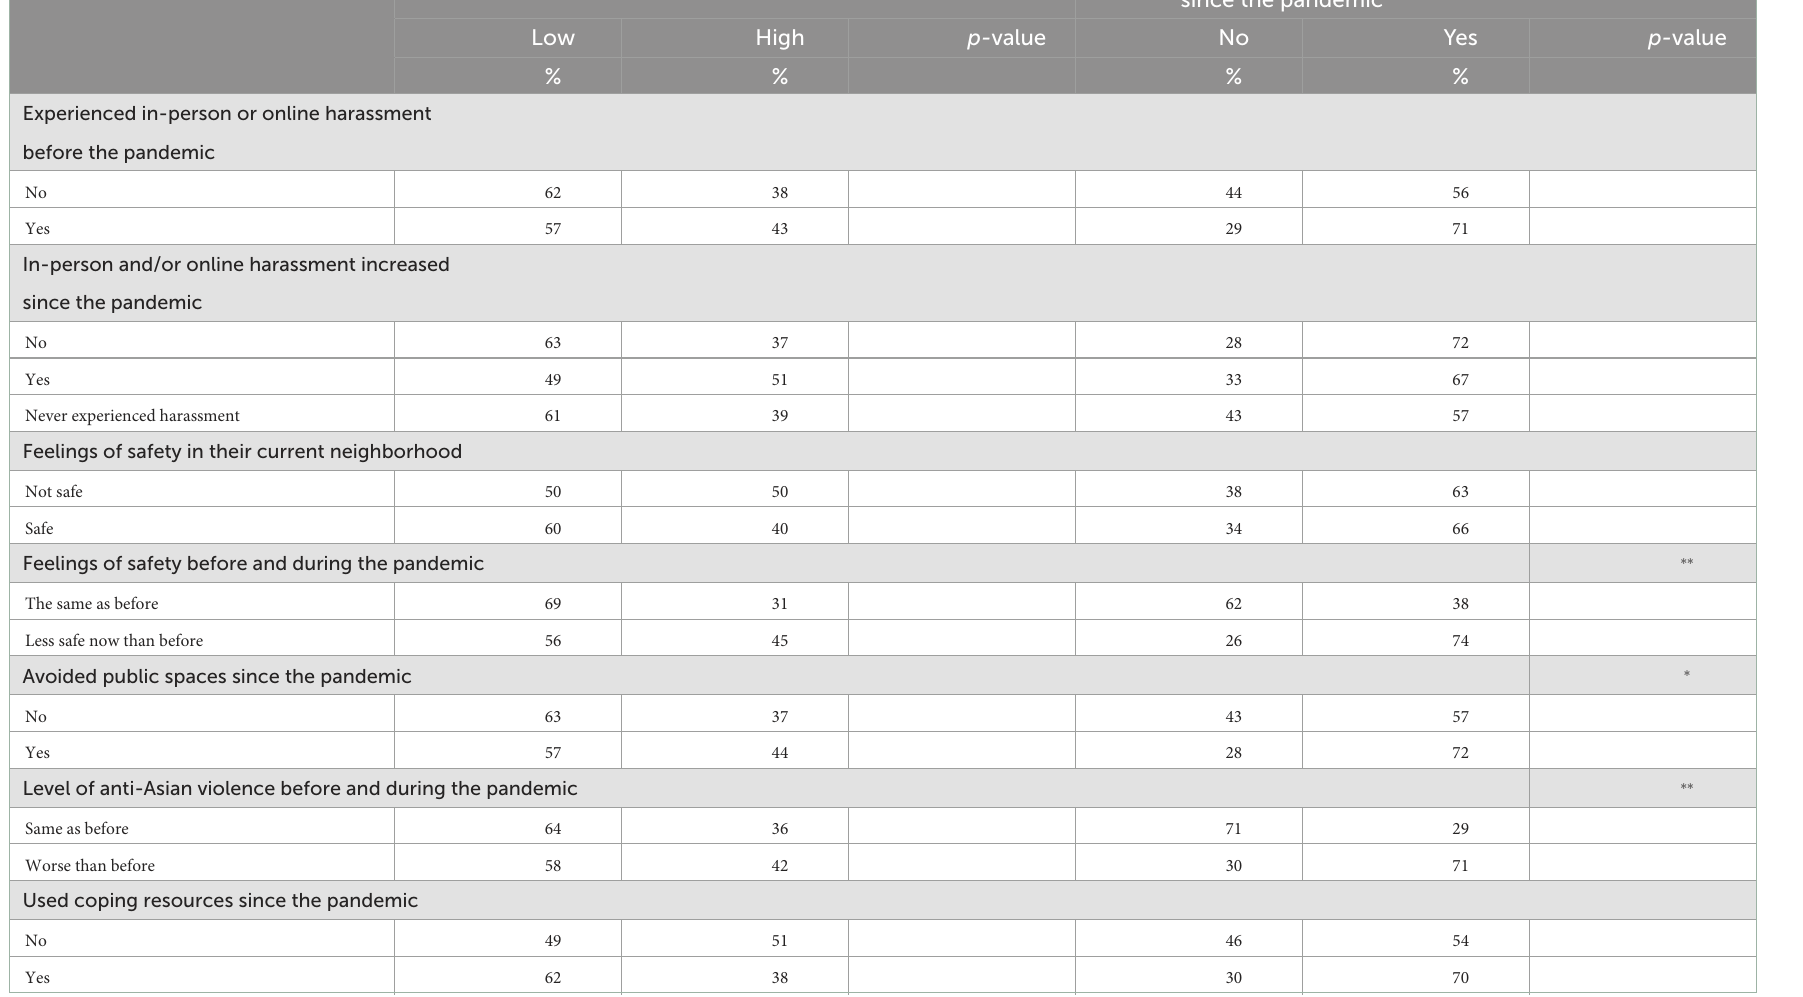
TABLE 3 Distribution of perceptions of safety and anti-Asian violence since the pandemic by depression severity among YAAHS respondents ( N = 176). Recent depression severity Depression severity increased since the pandemic Low High p- value No Yes p-